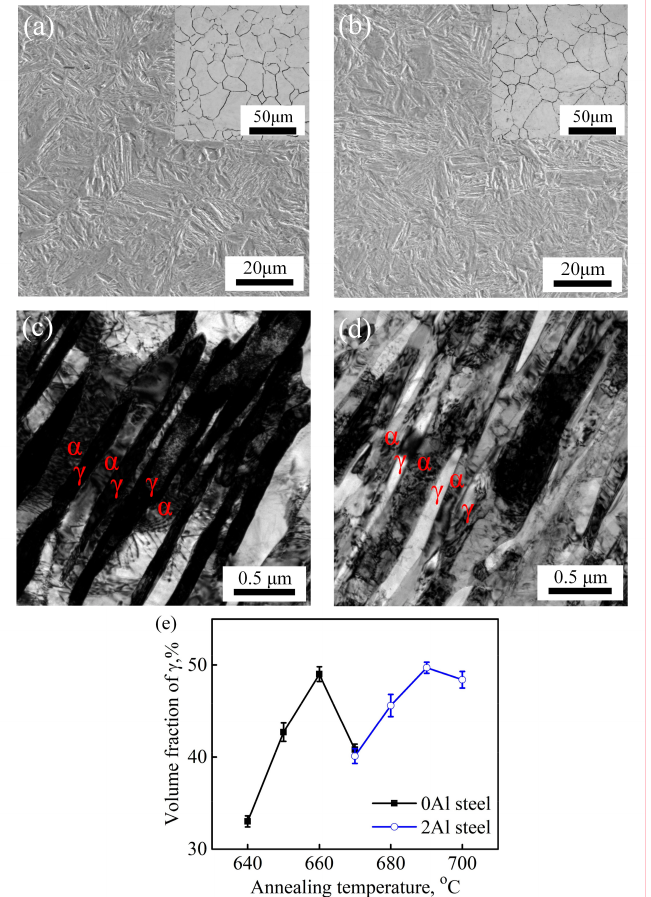
Figure 2. The typical lath martensite microstructure after austenitization and quenching treatment of ( a ) 0Al steel and ( b ) 2Al steel and the corresponding prior austenite grain boundaries in the inserted images at the upper right corner. TEM micrographs showing lath austenite and ferrite of ( c ) 0Al steel annealed at 650 ◦ C for 5 min and ( d ) 2Al steel annealed at 680 ◦ C for 5 min. ( e ) The volume fraction of austenite of 0Al steel and 2Al steel after being annealed at di ff erent temperatures for 5